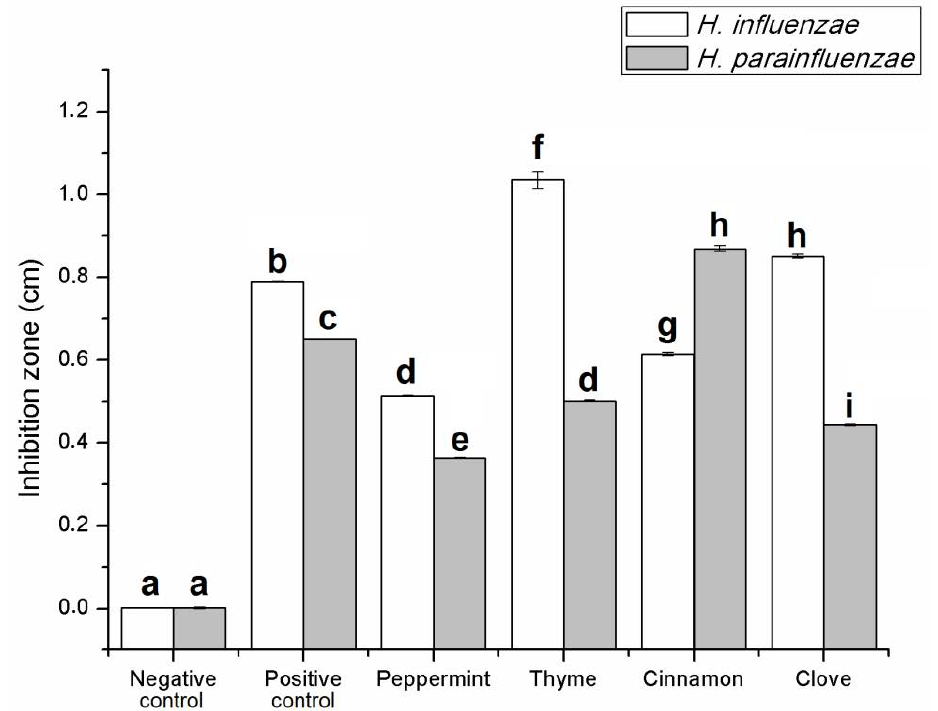
Figure 1. Antibacterial activity of essential oils (EOs) used in this study with direct bioautography (without TLC separation). The diameter of the inhibition zones was expressed in cm. Negative control—absolute ethanol; positive control—amikacin (equivalent to 0.05 mg antibiotic); 1 µ L of EO sample (equivalent to 0.2 mg undiluted EO) was applied. Error bars represent S.E.M. Lowercase letters ( a–i ) show pairwise comparison based on Tukey post-hoc test, p <